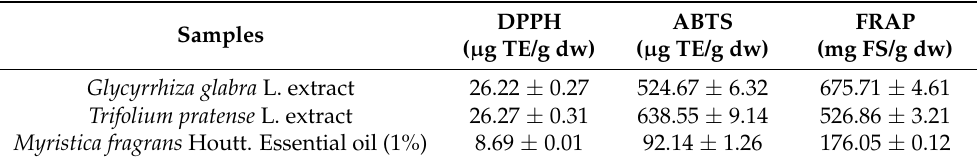
Table 2. Antioxidant capacity of plant extracts and essential oil. Samples